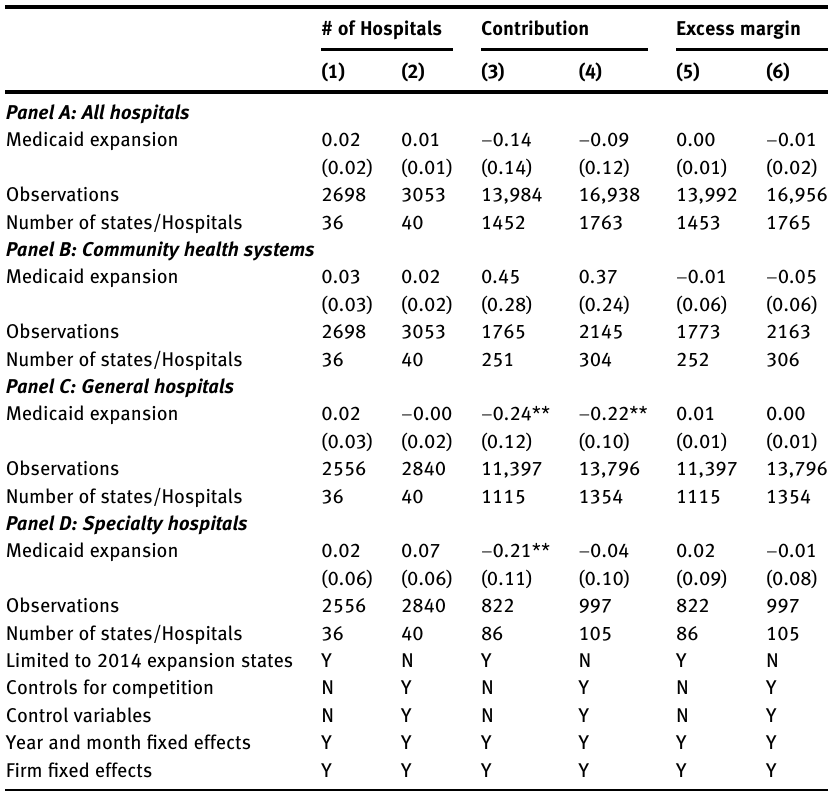
Table A  : Sensitivity